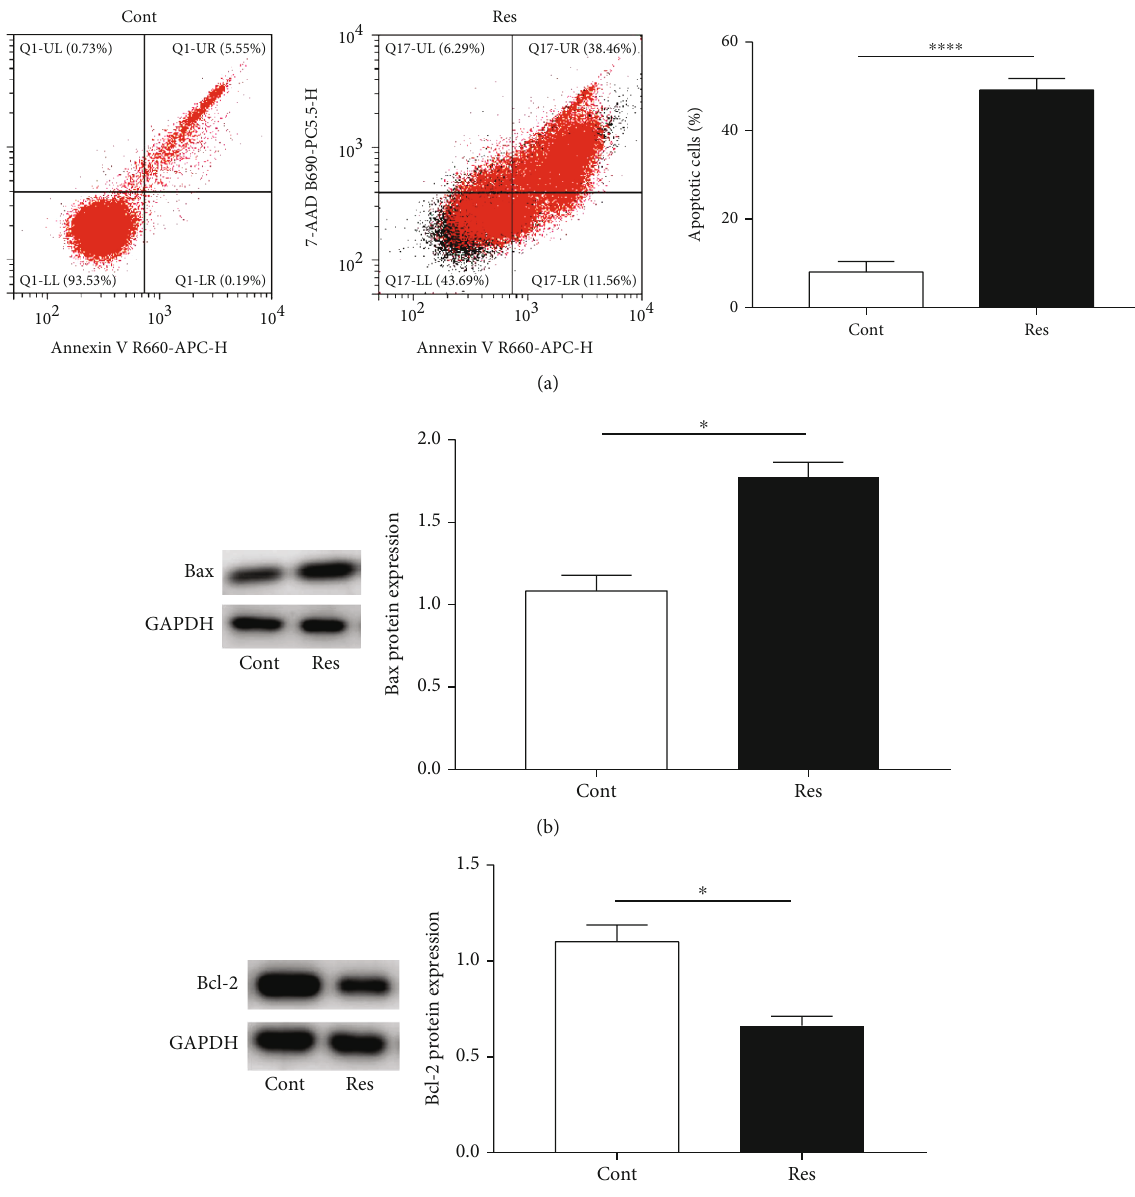
Figure 4: Res induces HSC apoptosis. (a) HSC apoptosis. (b) Bax protein expression. (c) Bcl-2 protein expression. Values are expressed as means ± SD . ∗ P < 0 : 05 and ∗∗∗∗ P < 0 : 0001